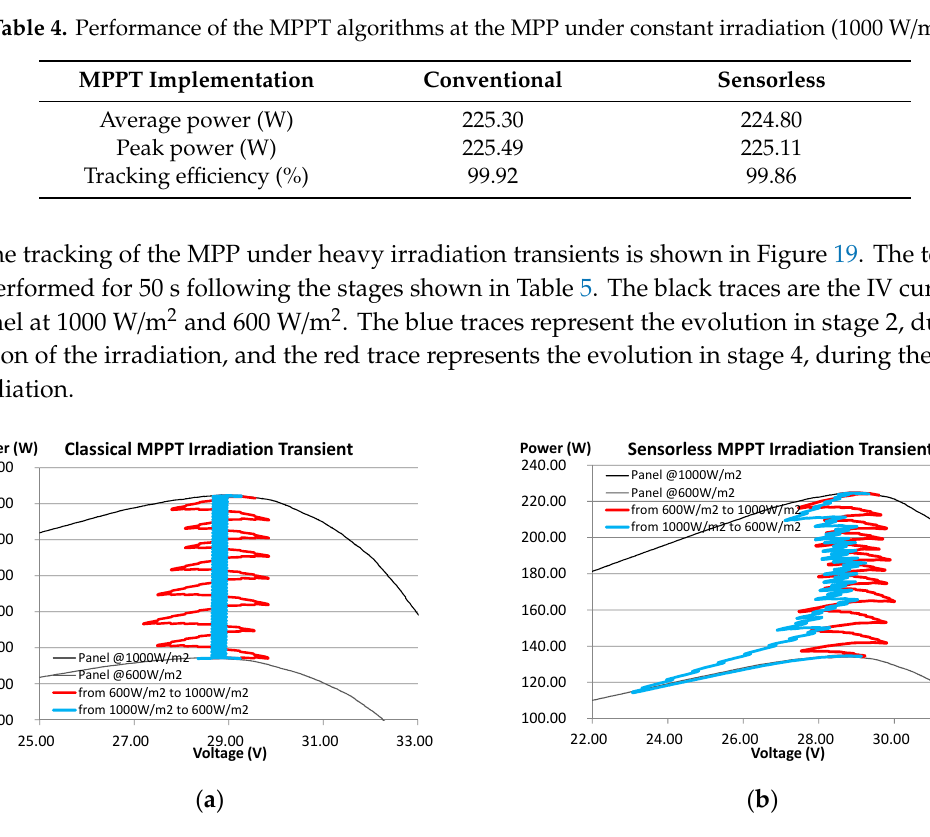
Table 5. Stages of the transient radiation test.